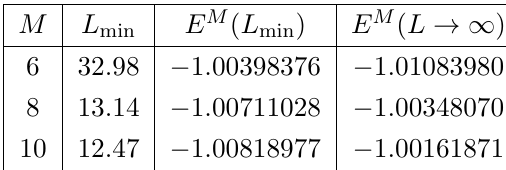
Table 6 . The local minimum E M ( L min ) and the asymptotic E M ( L ! 1 ) value of E M ( L ) for M = 6 ; 8 ; 10 in Schnabl